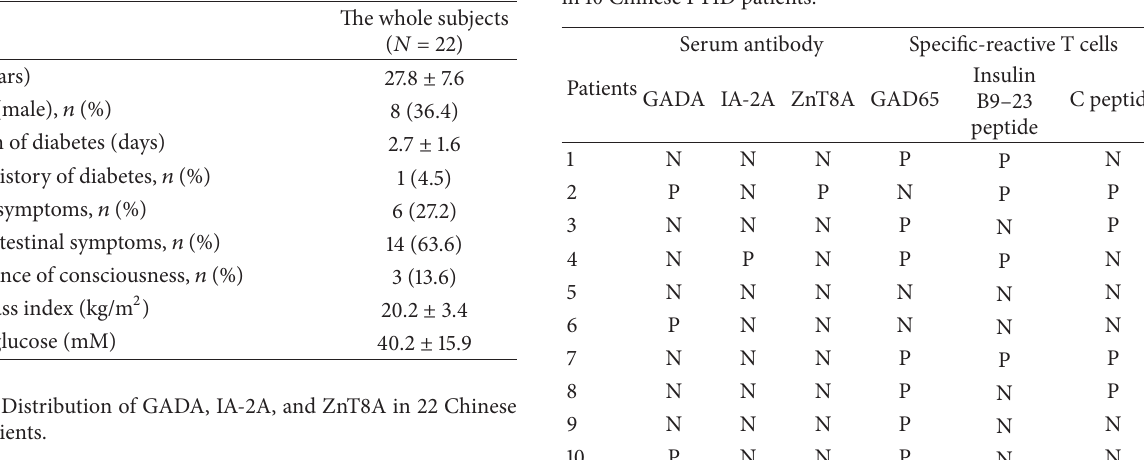
Table 1: Basic clinical characteristics of FT1D patients in this study.